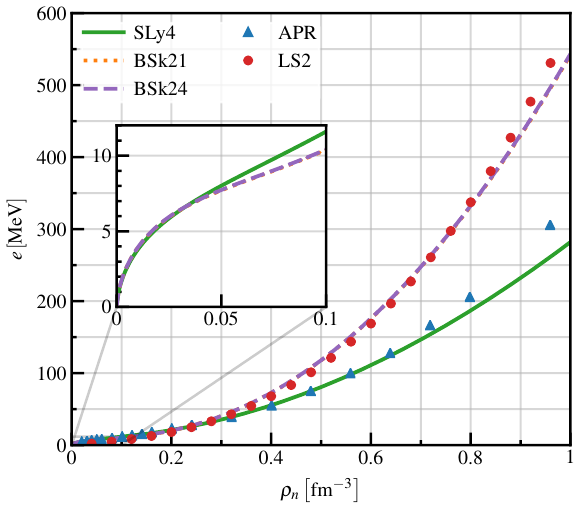
Figure 2. Energy per particle e in pure neutron matter for the three functionals used. The EoS calculated in references [48,49] (APR), and the one calculated in reference [50] (LS2) are also